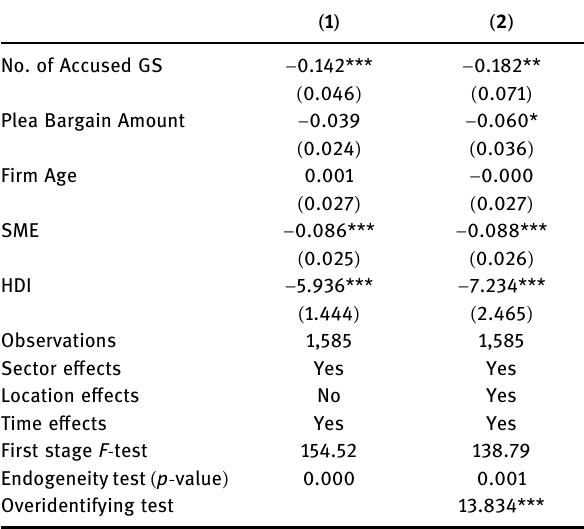
Dep. Variable: Bribe1 ( Firm is expected to pay bribe to